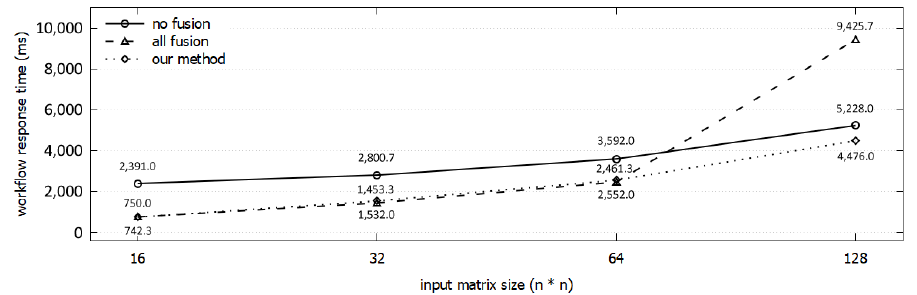
Figure 12. Change of the workflow response time of three methods by input matrix size.